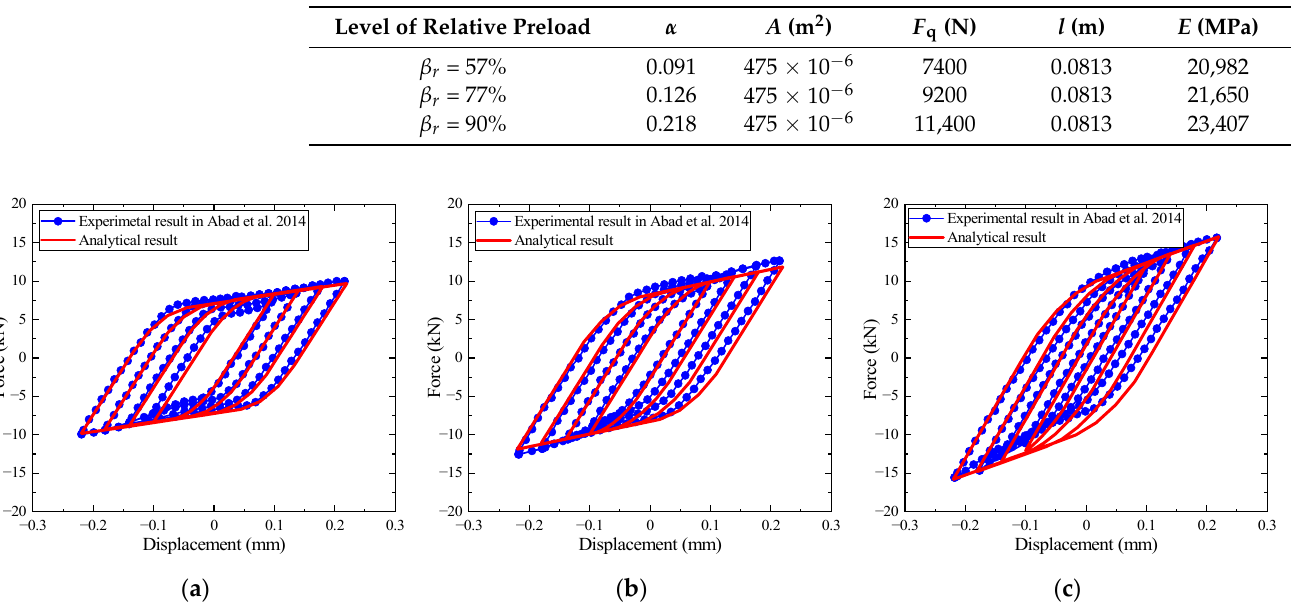
Figure 9. Comparisons under different levels of bolt preload: ( a ) comparison of 57% bolt preload; ( b ) comparison of 77% bolt preload; ( c ) comparison of 90% bolt preload [49].